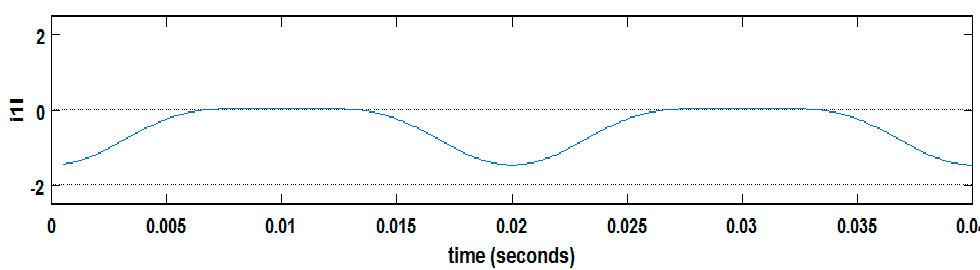
Figure A1. Upper arm current—proposed direct modulation.